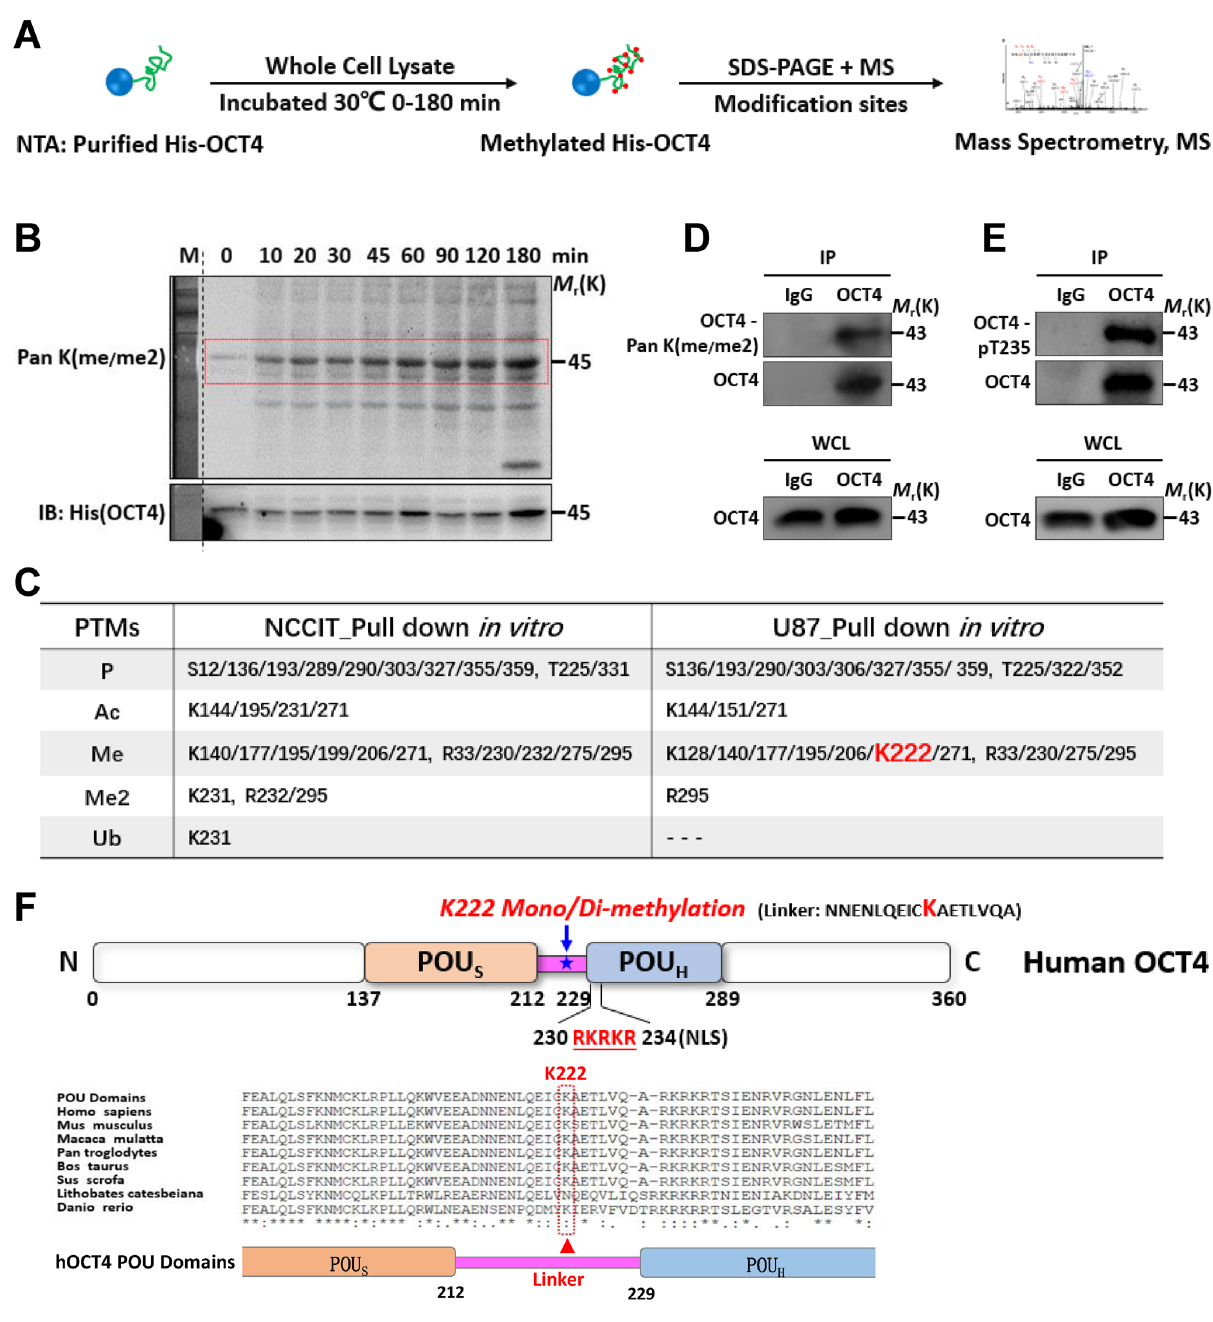
Figure 1. K222 site of human OCT4 protein can be methylated in vitro and in vivo. ( A ) Schematic representation of the cell-free system-based in vitro PTM analysis approach. ( B ) 1 μg of purified E. coli-derived His-OCT4 protein binding to the Ni–NTA beads (20 μl) was incubated with 0.2 mg of NCCIT whole cell lysate in 1 ml PMA buffer at 30 ℃ for varying periods from 0 to 180 min. Samples were subjected to SDS- PAGE and immunoblotted with the indicated antibodies. ( C ) Summary of the PTM profiles of recombinant His-OCT4 proteins in the cellular contexts of NCCIT and U87 cells. ( D , E ) NCCIT whole cell lysates were immunoprecipitated with anti-OCT4, and immunoblotted with anti-pan K(me/me2) ( D ) or anti-OCT4-pT235 (E). Cropped immunoblot images were presented. ( F ) Schematic representation of the OCT4 protein structure, highlighting the methylated K222 site at the linker region that connects the POU S with POU H domains. Multiple alignment of amino acid sequences at the linker region indicated that the K222 is a highly conserved residue across multiple